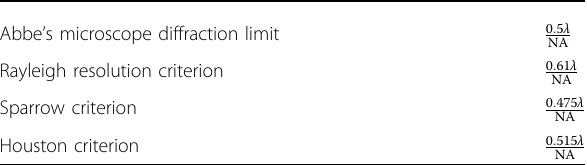
Table 1 De fi nitions of the diffraction limit of a light beam at